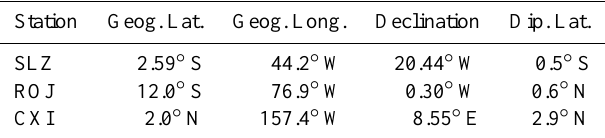
Table 1. Geographic and geomagnetic coordinates of the equatorial ionospheric stations. Figure 5. Occurrence of Ti (black bars) and Tp (white bars) parameters as function of 635 local time, showing seasonal variation, and irrespective of solar flux. Station Geog. Lat. Geog. Long.